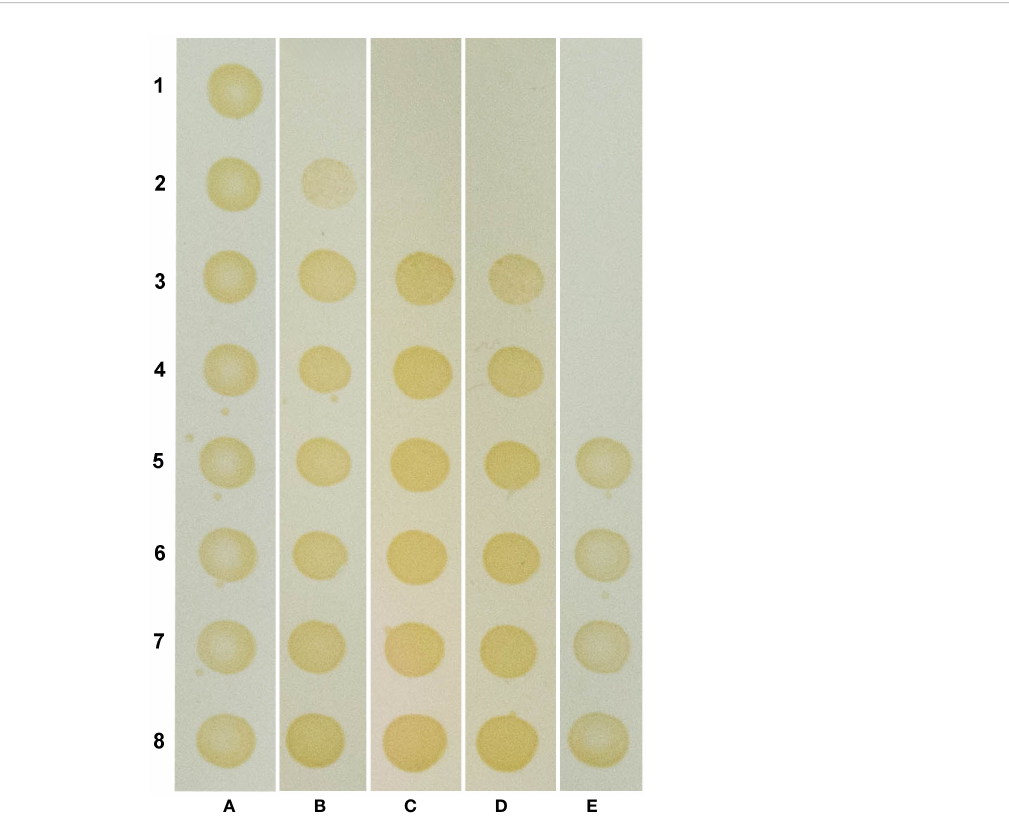
FIGURE 2 Compounds show a bactericidal effect against X citri . Rows 1 to 8 represent different concentrations of the compounds: 400, 200, 100, 50, 25, 12.5, 6.25 and 3.125 µg.mL -1 , respectively. Columns (A – E) represent different treatments: (A) negative control (NC), untreated cells; (B) oregano essential oil (OEO); (C) Carvacrol (CAR); (D) Thymol (THY), and (E) positive control (PC), 20 µg.mL -1 kanamycin (rows E1-E4), and vehicle control (VC), 1% ethanol (rows E5-E6).